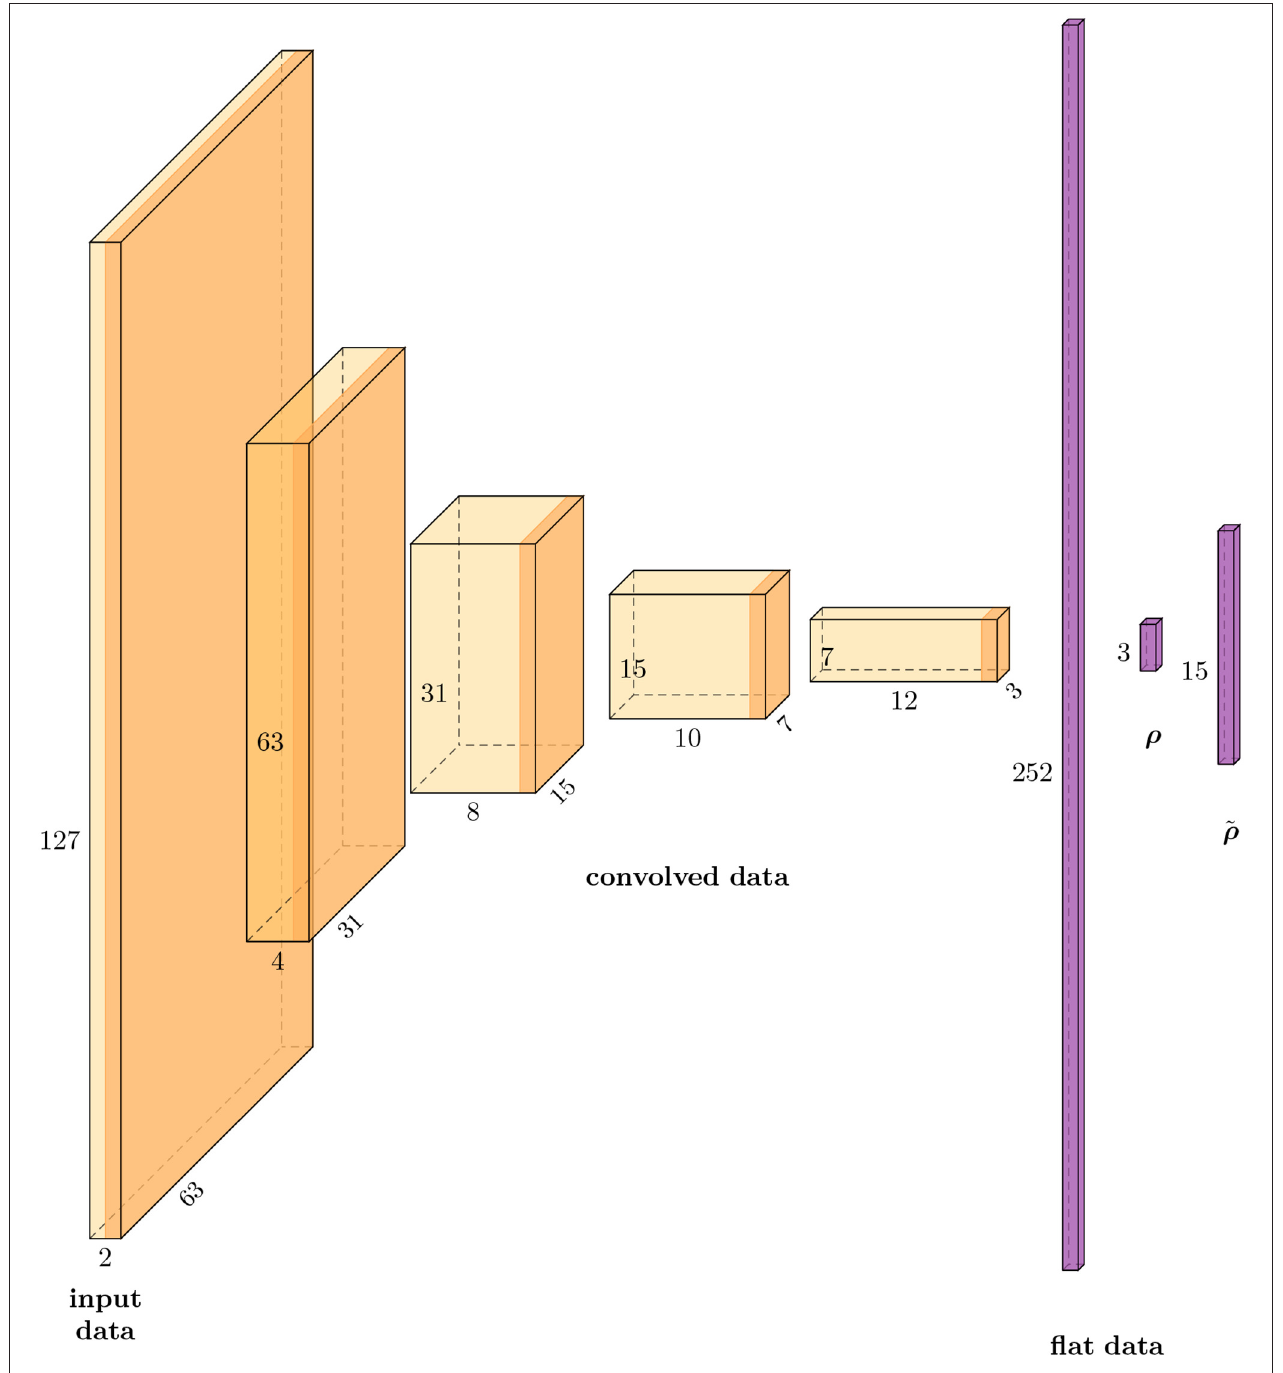
FIGURE 3 | Schematic illustration of the data sizes in each layer of the CAE -3 network that was used in the numerical example: Four convolutional layers, one reshape of the data to the vector (flat data), a full linear layer that reduces the data to ρ and a linear layer without activation for the decoding to ˜ ρ